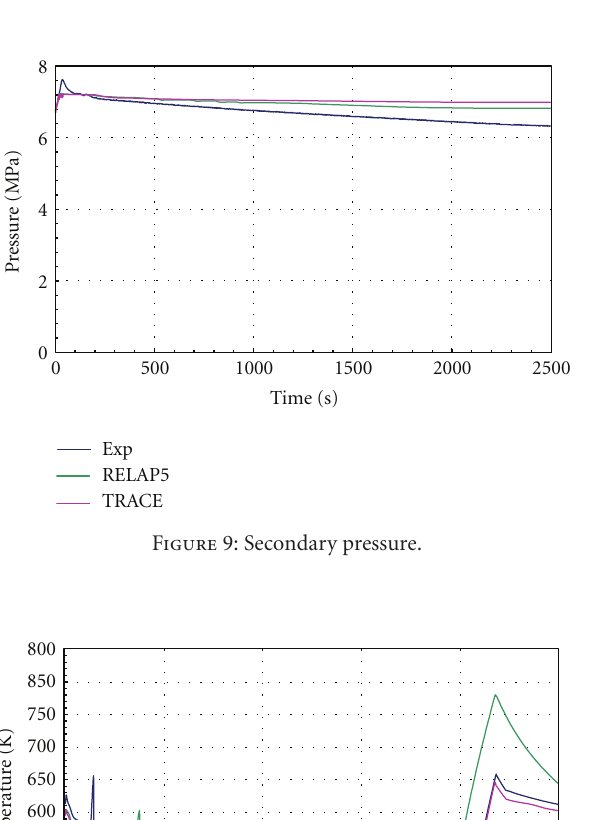
Figure 11: Heater rod surface temperature at the top of the core.